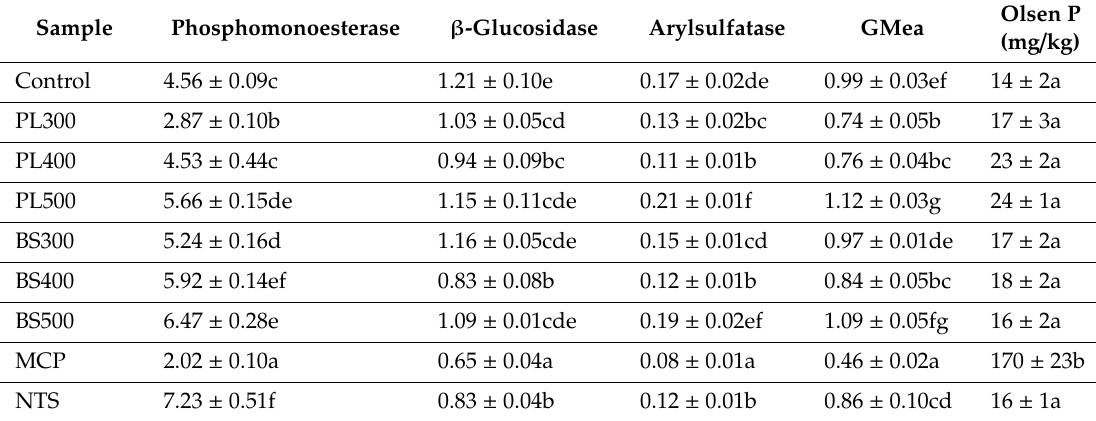
Table 1. Soil enzyme assay and Olsen P results. Data for enzyme activity are in µ mol p-nitrophenol g − 1 h − 1 . Di ff erent letters within the same column indicate that the data are statistically significant ( p < 0.05, Tukey´s test).